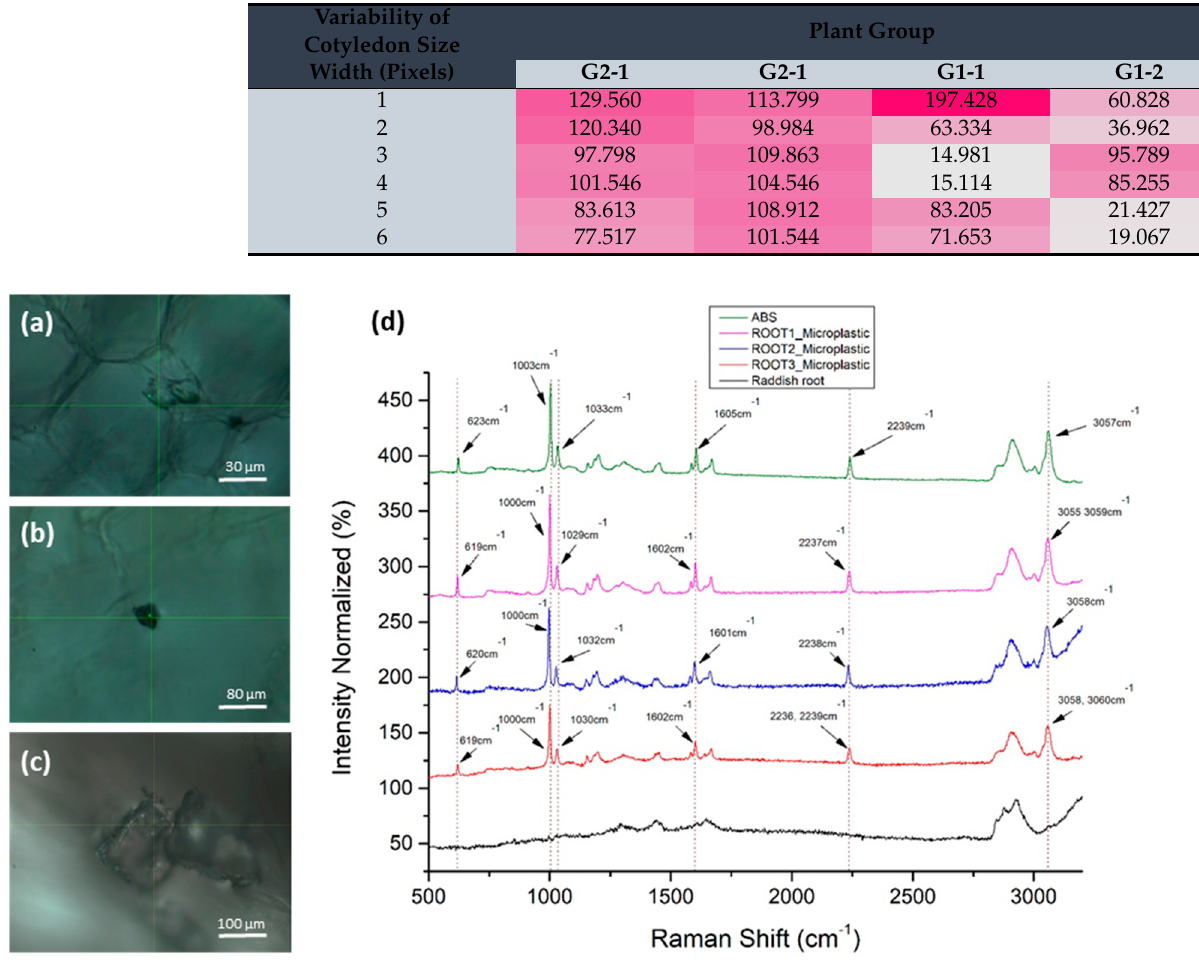
Figure 4. Detection of ABS MPs in radish roots: ( a – c ) Confocal MPs images in root sections (brightfield); ( d ) Raman spectra of the experimentally detected MPs (purple, blue and red), radish root background (black) and ABS powder (green line).